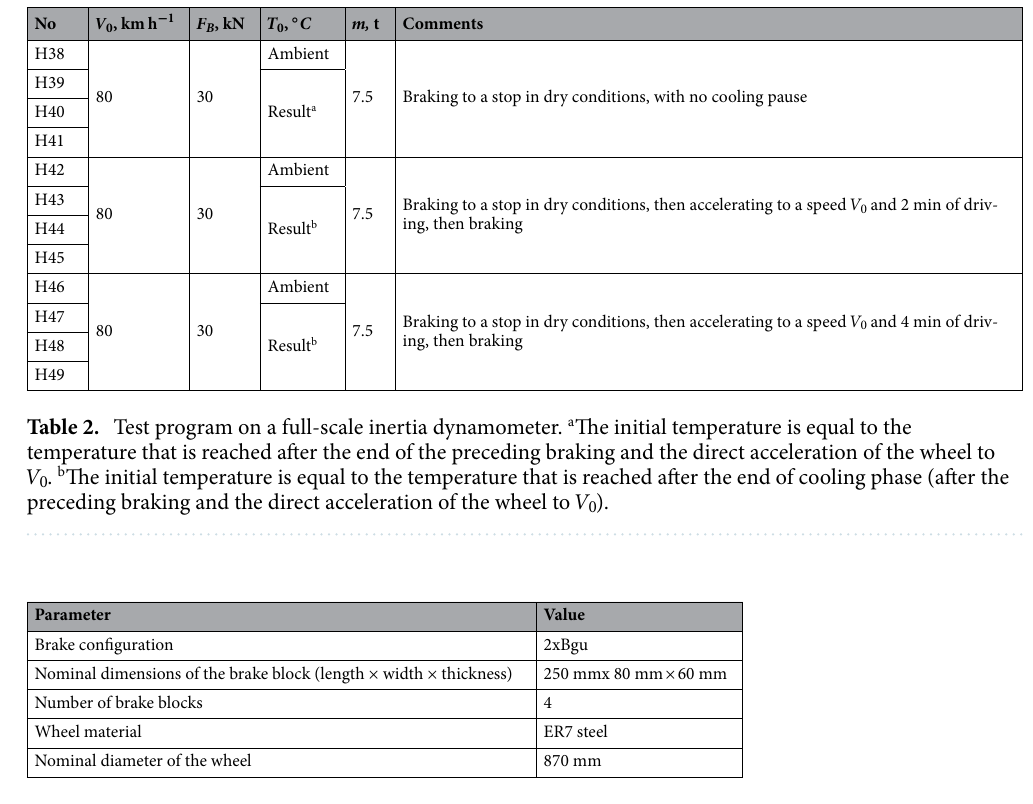
Table 3. Test conditions on a full-scale inertia